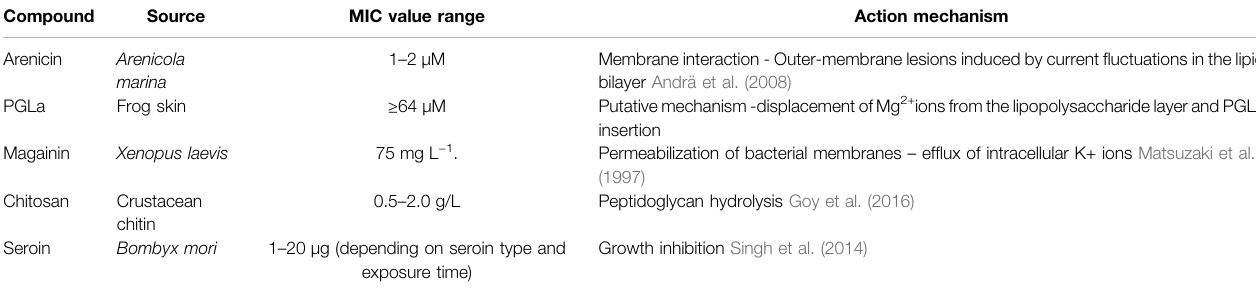
TABLE 2 | Mechanism of action of antibacterial compounds of animal origin against Gram-negative strains.